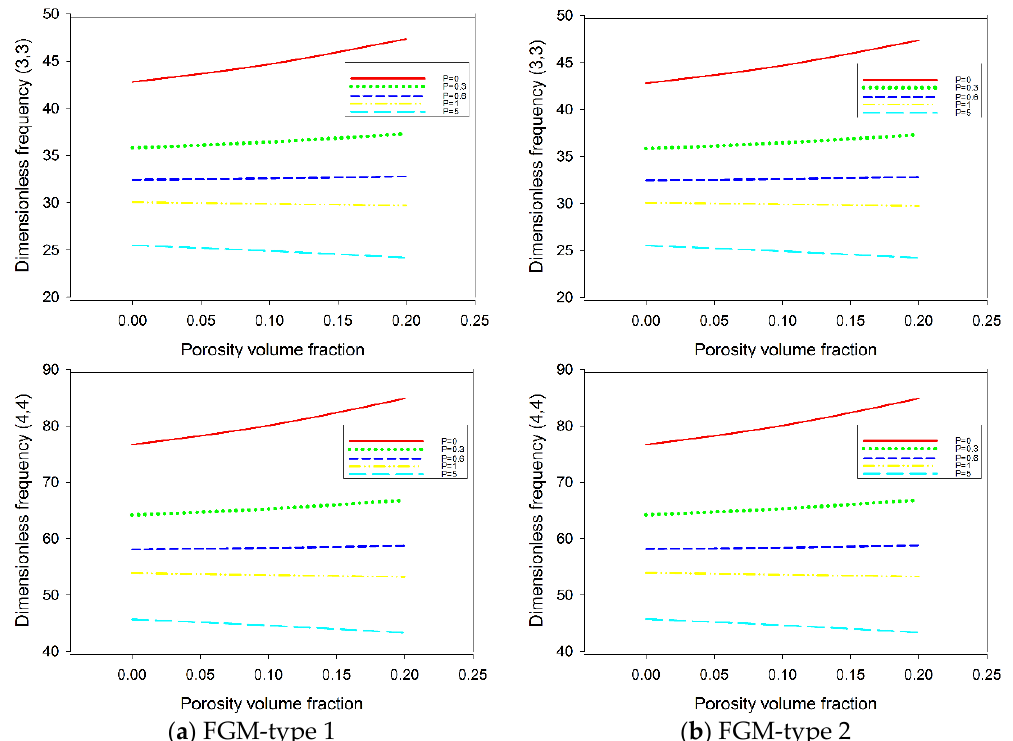
Figure 5. Dimensionless frequency of FG porous hyperbolic paraboloidal shell against different power-law indices and porosity volume fractions distributions: ( a ) FGM-type 1; ( b ) FGM-type 2. Appl. Sci. 2017 , 7 , 1252 15 of 20